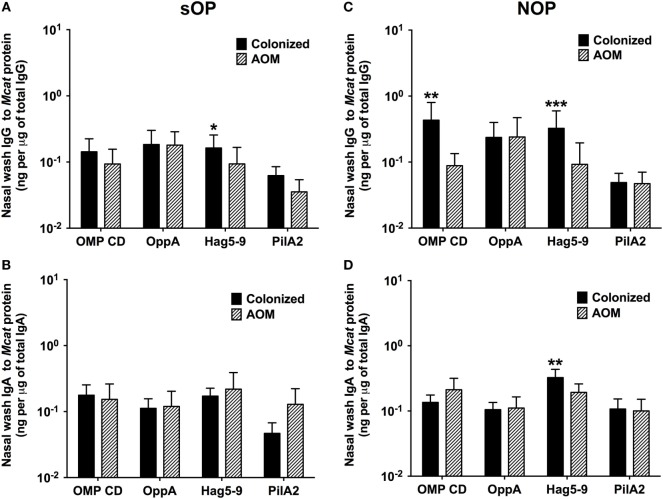
Mucosal antibodies to Moraxella catarrhalis (Mcat) proteins at healthy visits with Mcat nasopharyngeal (NP) colonization vs. acute otitis media (AOM) visits in stringently defined otitis prone (sOP) and non-otitis prone (NOP) children. Nasal wash IgG and IgA against Mcat proteins outer membrane protein (OMP) CD, oligopeptide permease A (OppA), Hag5–9, and Pilin A clade 2 (PilA2) were detected by using enzyme-linked immunosorbent assay for children age 6–36 months old. (A,B) 107 Mcat NP colonization visits of 47 sOP children and 42 Mcat-caused AOM visits of 31 sOP children were analyzed for nasal wash (A) IgG and (B) IgA. (C,D) 130 Mcat NP colonization visits of 61 NOP children and 43 Mcat-caused AOM visits of 37 NOP children were analyzed for nasal wash (C) IgG and (D) IgA. Mcat protein-specific IgG and IgA concentrations (ng/ml) were normalized with total IgG and IgA concentrations (μg/ml) in nasal wash, respectively, for comparison. Data are shown as geometric mean ± 95% confidence interval. Mann–Whitney test was used for comparison. *P < 0.05, **P < 0.01 and ***P < 0.001 comparing Mcat NP colonized vs. AOM visits in the same population of children.